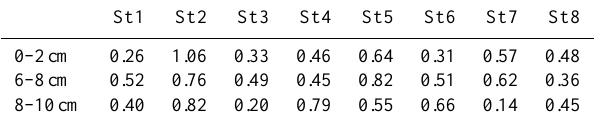
Table 1. Dimensionless linear NH + for different sediment depths at St 1–8.